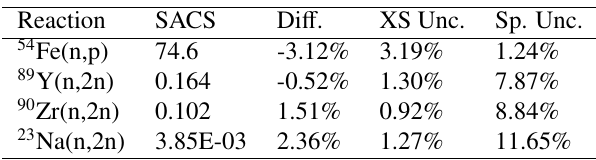
Table 3. Comparison of 235 U SACS measured in this work with data calculated using ENDF / B-VII.1 PFNS and IRDFF-1.05 cross sections.